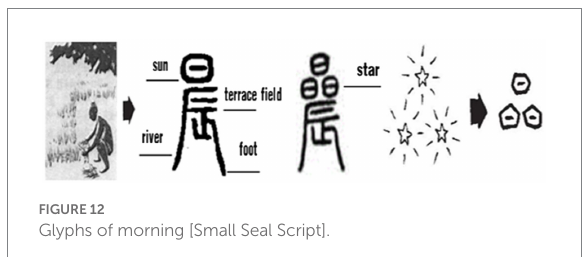
FIGURE 12 Glyphs of morning [Small Seal